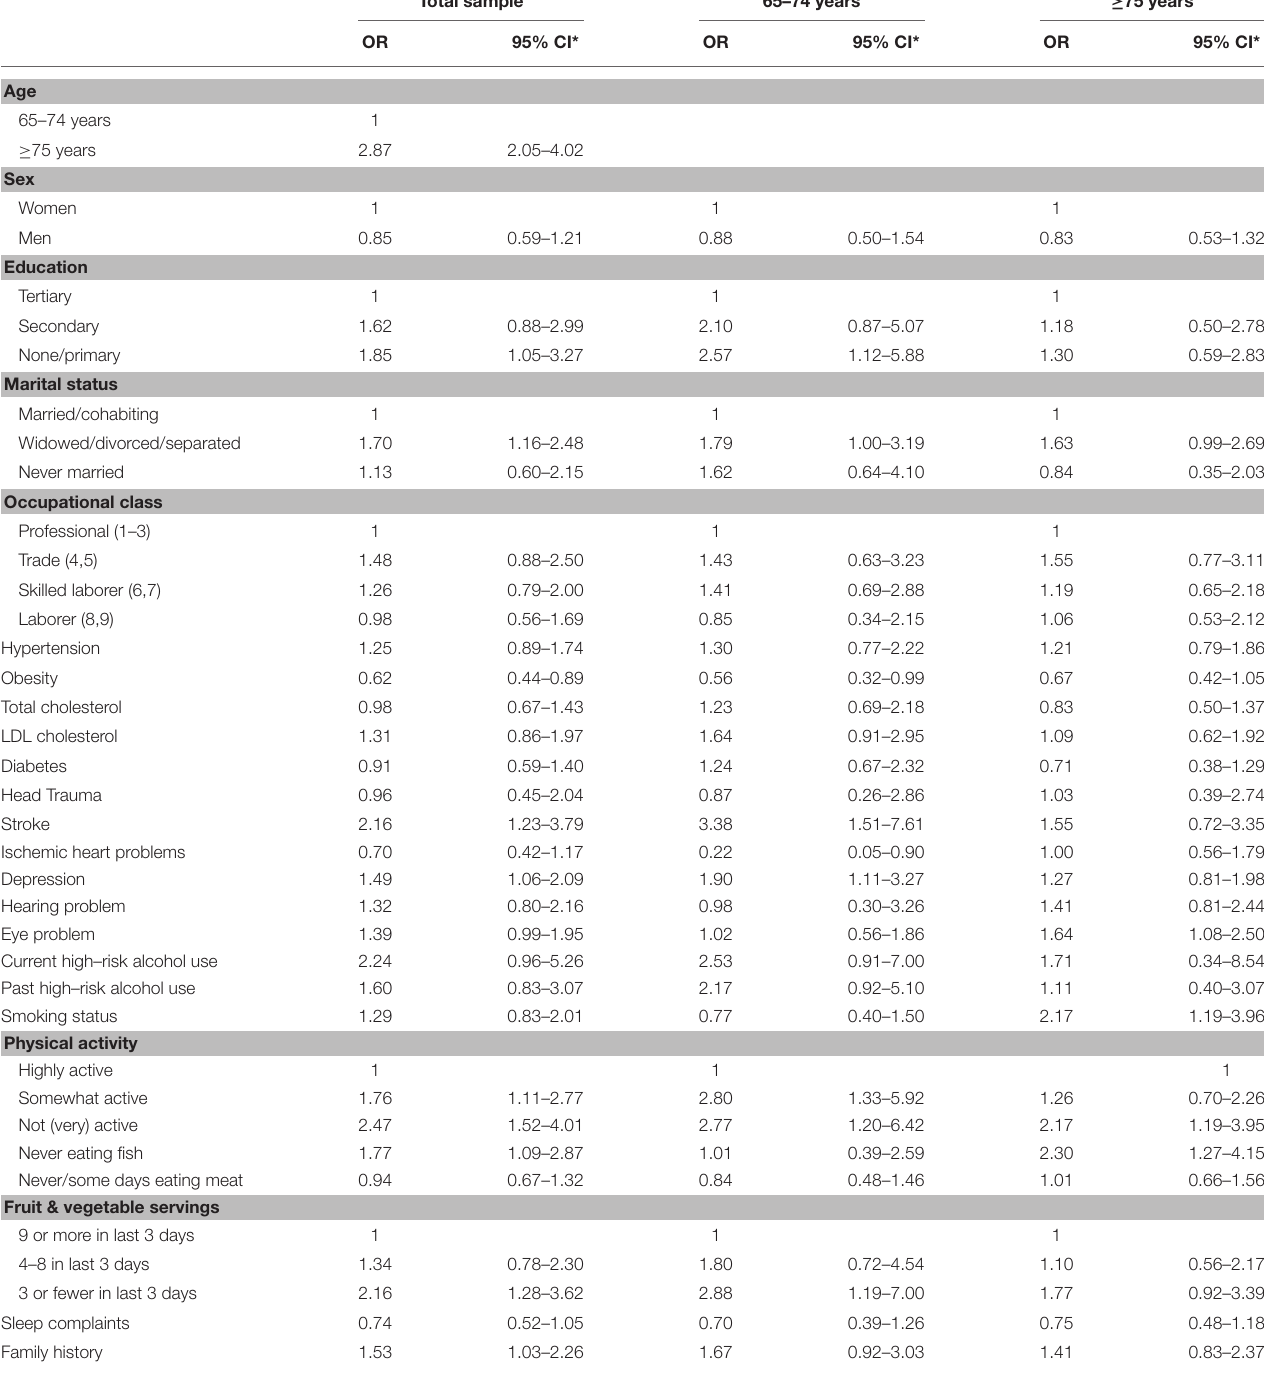
TABLE 2 | Univariable associations between potential risk factors and incident dementia in the total sample ( n = 1,846), and stratified by